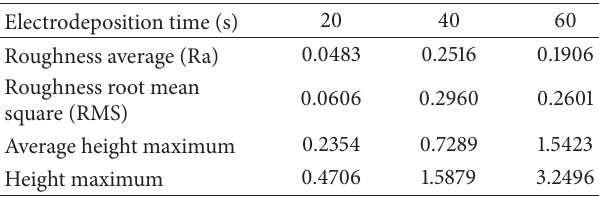
Table 2: Roughness measured by AFM for CIGS thin films prepared at electrodeposition potential of −